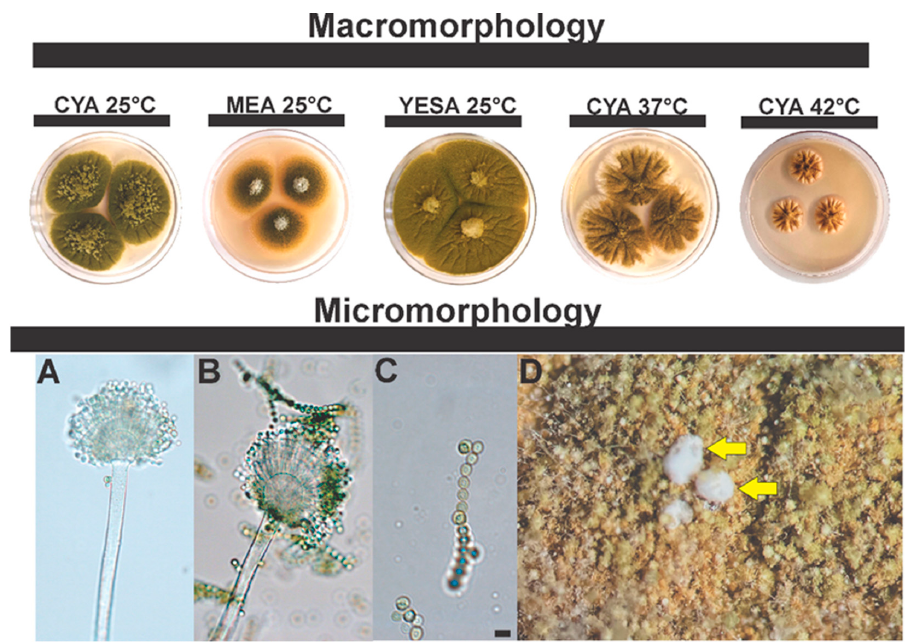
Figure 8. Colonial and microscopic morphology of Aspergillus saccharicola sp. nov. (117-IT-SGC = IBT 36126). ( A , B ) Conidiophores; ( C ) Conidia (scale bar 5 µm); ( D ) Sclerotia (CYA 37 °C), yellow arrows indicate the structures. Colony characters : On CYA 25 °C, 7 days: Olive green colonies, with aerial mycelium in the central region, abundant sporulation, velvety surface; exudates present (colorless); soluble pigments, and sclerotia absent. On MEA 25 °C, 7 days: Light green colonies, aerial mycelium in the central region. Pigments and sclerotia are absent; transparent exudates. On YESA 25 °C, 7 days: green colonies; velvety appearance; aerial mycelium; soluble pig- ments, exudates and sclerotia absent. Micromorphology : Conidial heads brown, uniseriate and biseriate. Conidiophores (66.5 ± 10.3 µm) with stipes hyaline, finely roughened, 12.6 ± 1.3 µm. Vesicles globose to subglobose, 30.4 ± 5.3 µm wide. Metulae, 10.4 ± 2 µm; phialides, 5 ± 0.5 µm. Conidia smooth to slightly rough, 4.7 ± 0.6 µm. Supplementary Materials: The following supporting information can be downloaded at: www.mdpi.com/xxx/s1, Figure S1: Maximum-likelihood tree of Aspergillus parasiticus clade based on combined dataset sequences ( ITS+niaD) ; Table S1: Description of the samples from this study. Strains, substrate of origin, haplotypes and GenBank accession numbers; Table S2: Dataset for ge- netic distance analysis; Table S3: The high-resolution MS/MS spectrum of dereplicated metabolites of Aspergillus annui sp. nov. and Aspergillus saccharicola sp. nov. Author Contributions: Conceptualization, J.J.S.; Funding acquisition, B.T.I., M.H.T. and M.H.P.F.; Investigation, J.J.S., J.C.F., T.O.L. and X.W.; Project administration, B.T.I.; Resources, J.J.S., M.H.P.F., B.T.I., M.H.T., J.C.F., T.O.L. and X.W. Writing—original draft, J.J.S.; Writing—review and editing, J.J.S., M.H.P.F., M.H.T., J.C.F., T.O.L., X.W. and B.T.I. All authors have read and agreed to the pub- lished version of the manuscript. Funding: This research was funded by Fundação de Amparo à Pesquisa do Estado de São Paulo (FAPESP) (Process 2018/25552–0; J. J. Silva grant # 2018/25597–3); Conselho Nacional de Desenvol- vimento Científico e Tecnológico (CNPQ) (Process 303732/2018-0). Institutional Review Board Statement: Not applicable. Data Availability Statement: The sequences newly generated in this study have been submitted to the GenBank database.